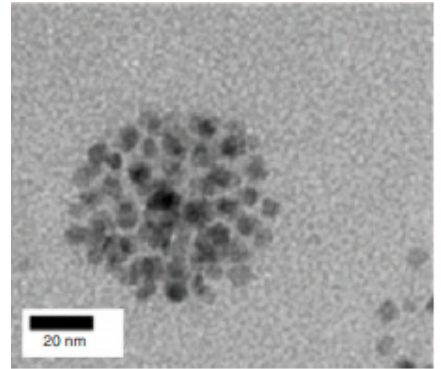
Figure 4. Transmission electron microscopy (TEM) micrograph depicting a raspberry SPION with uranyl acetate (1%) staining. Reprinted from Hobson, N.J.; Weng, X.; Siow, B.; Veiga, C.; Ashford, M.; Thanh, N.T.; Schätzlein, A.G.; Uchegbu, I.F. “Clustering superparamagnetic iron oxide nanoparticles produces organ-targeted high-contrast magnetic resonance images.” Nanomedicine 14 (2019) 1135.